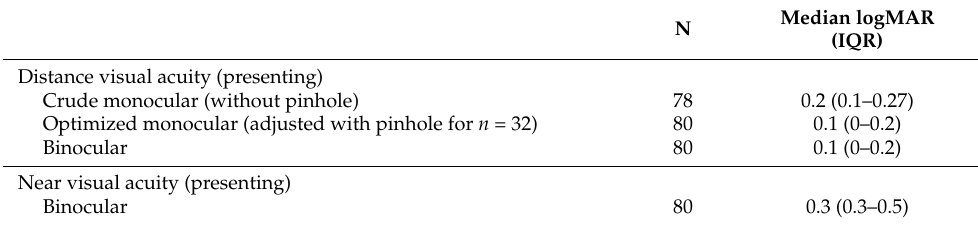
Table 1. Characteristics of visual acuity measurements.